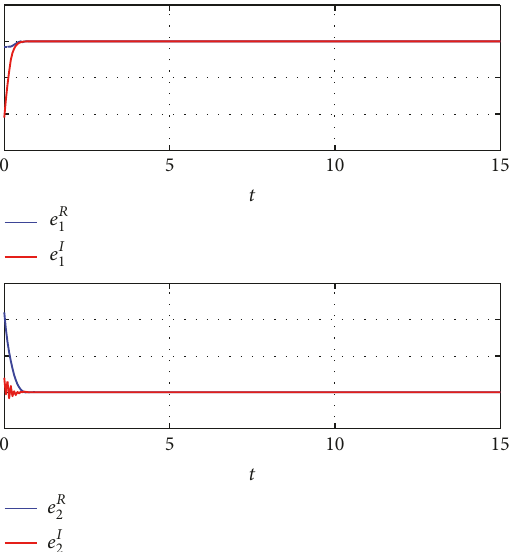
Figure 5: Time responses of the variables 𝑧 1 , 𝑧 2 , ̃𝑧 1 , and ̃𝑧 2 in 3D and 2D spaces without controller for example